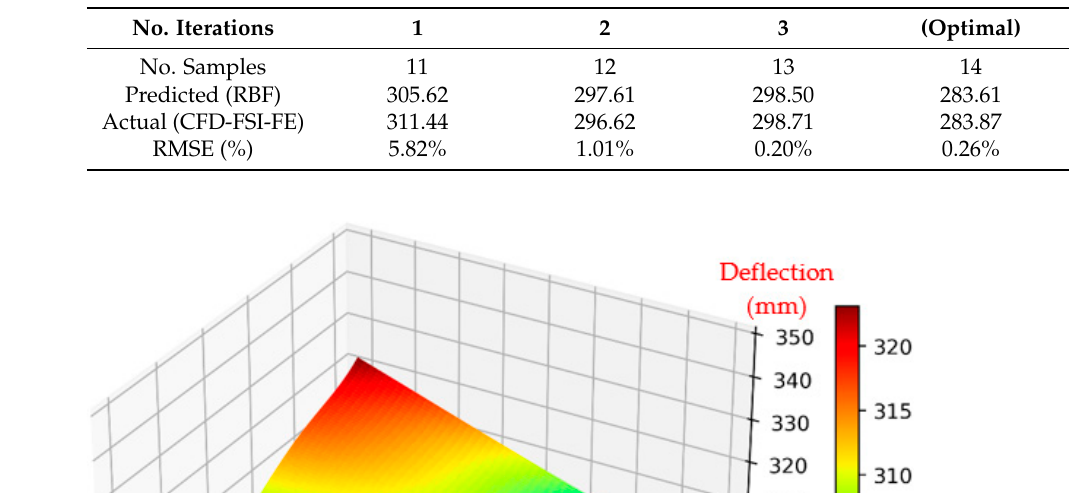
Table 4. RBF optimization summary.